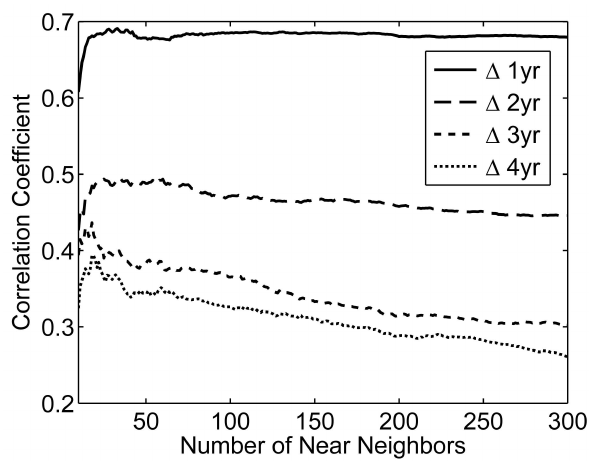
Fig. 5. Correlation between forecasted and observed beach width for town at alongshore location 50 (of 100 towns, with γ r = 1.5myr − 1 , for a 5000-yr time series), plotted against the number of neighbors used to generate the prediction. Predictions are made at 1 (solid), 2 (large dash), 3 (small dash), and 4 (dotted) years for- ward in the time series.